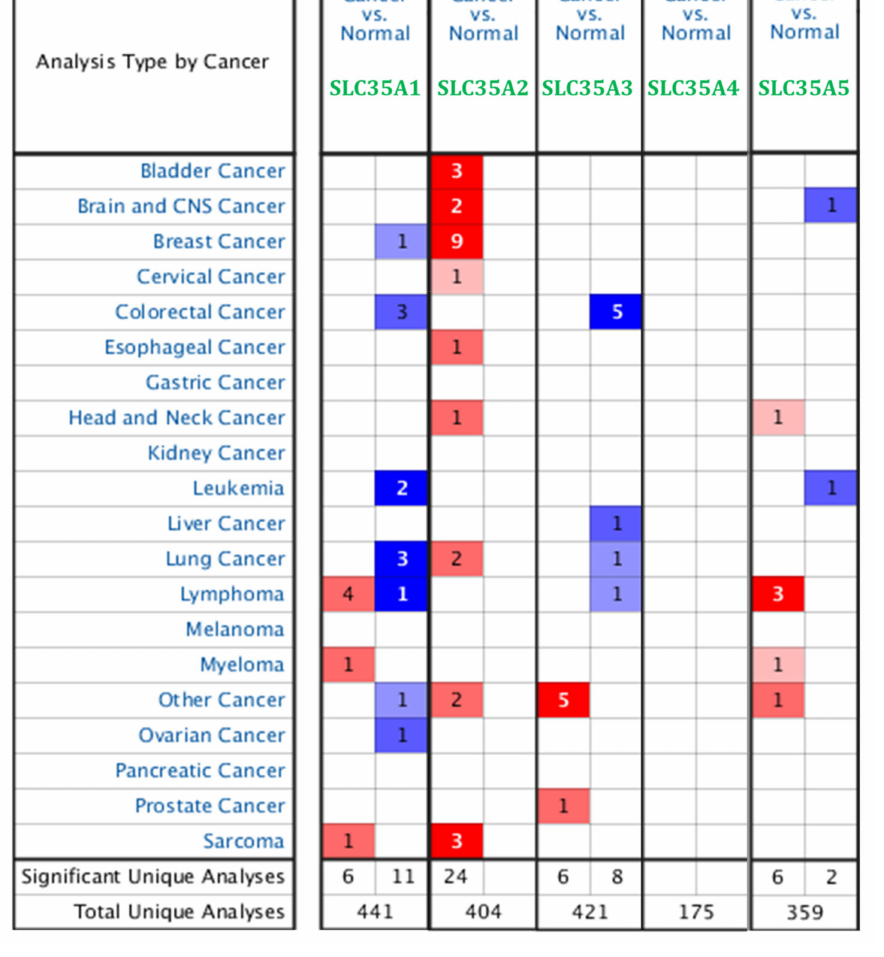
Figure 1. Pan-cancer analysis and overview of mRNA expression levels of solute carrier 35A (SLC35A) family genes in 20 common types and subtypes of cancer from the Oncomine platform database. Dysregulation of each individual SLC35A gene in targeted cancer tissues measured by mRNA expression levels was compared to their normal counterparts using Student’s t -test. The cutoff of parameters were restricted as follows: p < 0.05; fold change of >2; gene rank: top 10%. The number of datasets that met those thresholds is presented as a number inside the table cells while the colors indicate the trend of gene expression (red for up-regulation and blue for down-regualtion, respectively), and the intensity of the colors indicates the degree of abnormal